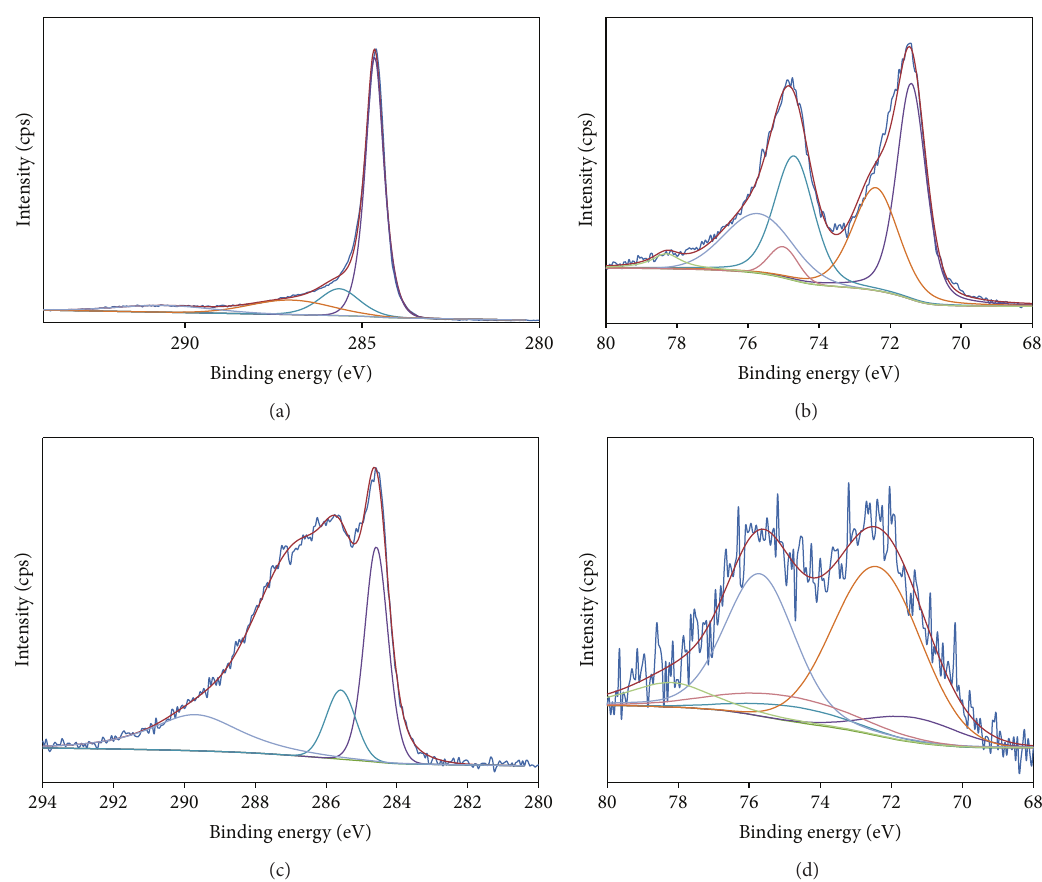
Figure 4: C 1s (a, c) and Pt 4f (b, d) high-resolution XPS spectra of (a, b) 3.5 wt% Pt/CNTs and (c, d) 3.5 wt% Pt/RGO@SiO 2